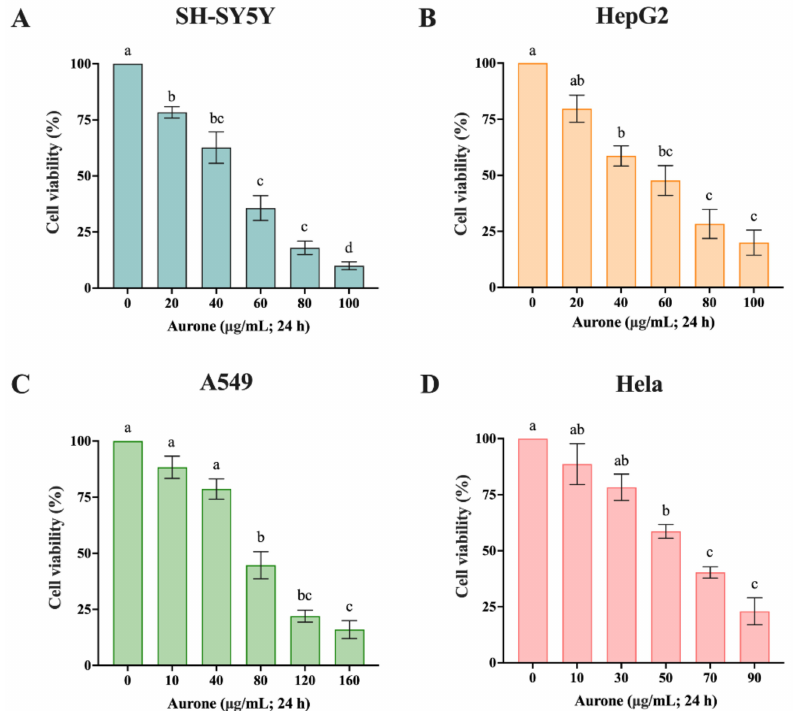
Figure 4. Effects of aurone on the cell viability of different cells. The different lowercase alphabets indicate significant differences between any two sets of treatments ( p ≤ 0.05). ( A ) SH-SY5Y cells, ( B ) HepG2 cells, ( C ) A549 cells, and ( D ) HeLa cells. The data were shown as means ± SD of three independent experiments. p -value: a, b, c, and d represent significant differences ( p < 0.05).